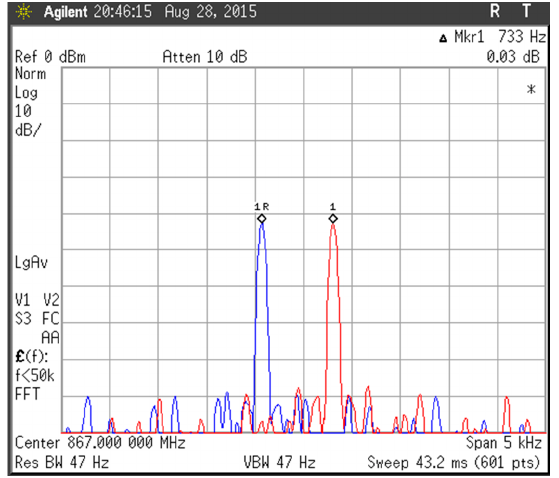
Figure 19. Measured frequency resolution of the fractional-N PLL. The two curves are the spectra of PLL’s two outputs with 733 Hz frequency difference which is controlled by configuring the PLL frequency setting register.